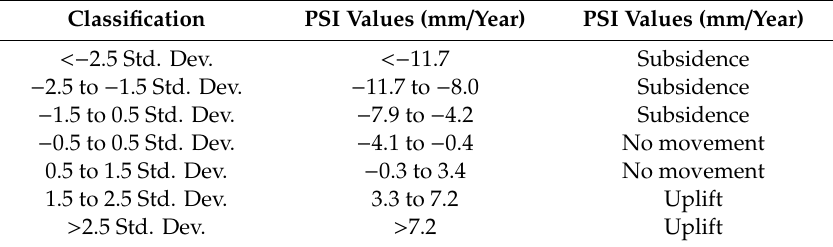
3 Table 2. Values used for thresholding the PSI data of time series A.